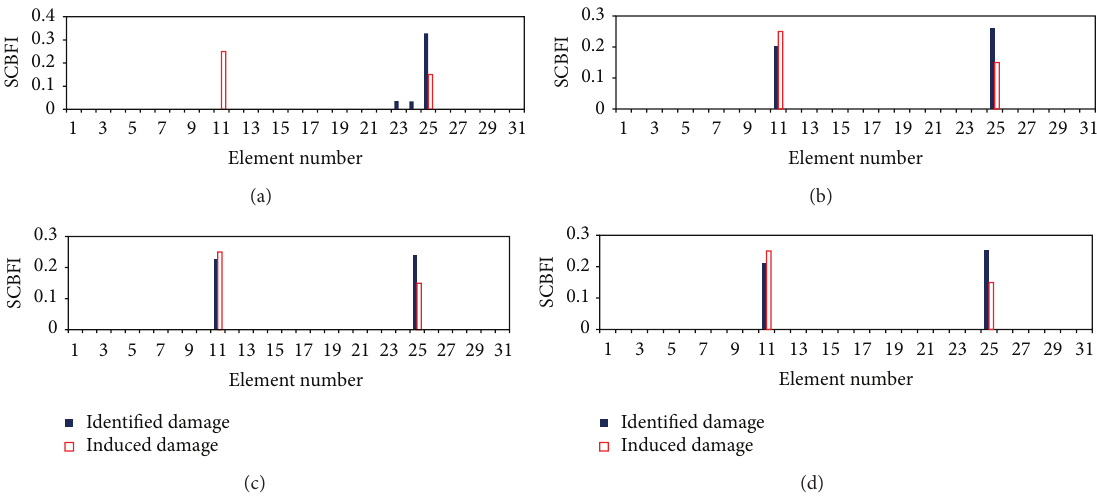
Figure 3: Damage identification for 31-bar truss for case 1 considering (a) 1 mode, (b) 2 modes, (c) 3 modes, and (d) 4 modes.